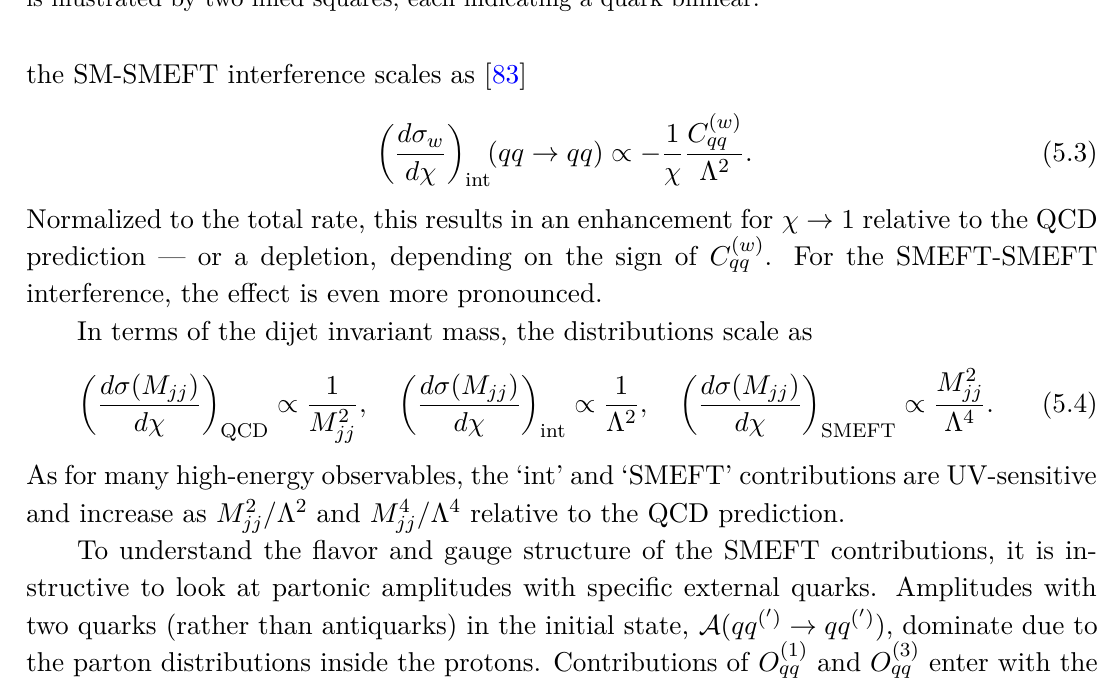
Figure 3 . Illustration of the two different topologies of SMEFT contributions to dijet production at the example of ud → ud . Left: t -channel topology with insertion of ( aa ) ( − ) . Right: u -channel topology, involving a charged current with insertion of ( aa ) (3) . The insertion of SMEFT operators is illustrated by two filled squares, each indicating a quark